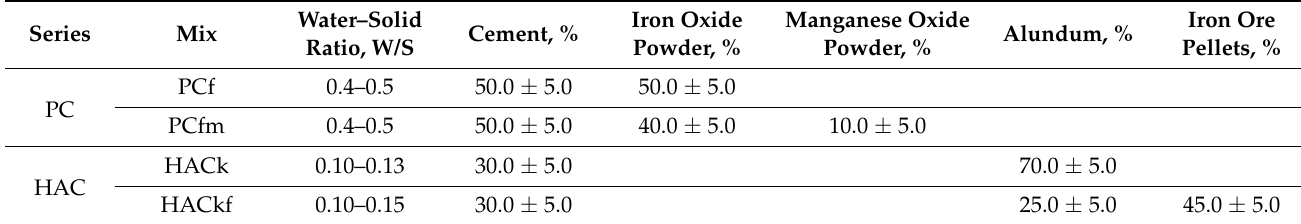
Figure 4. Photos of concrete samples made for research.